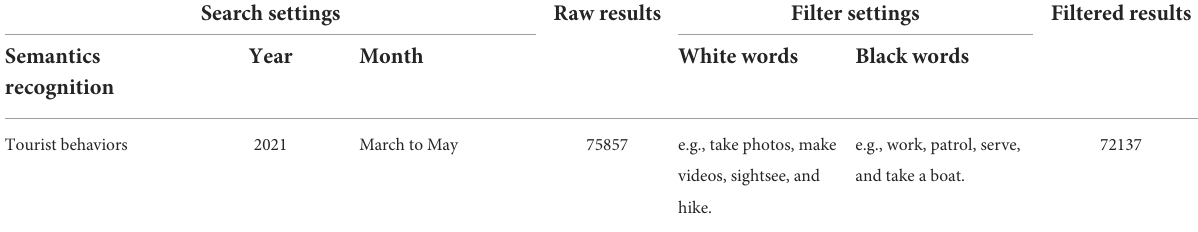
TABLE 2 The search settings and results of Sina Weibo.